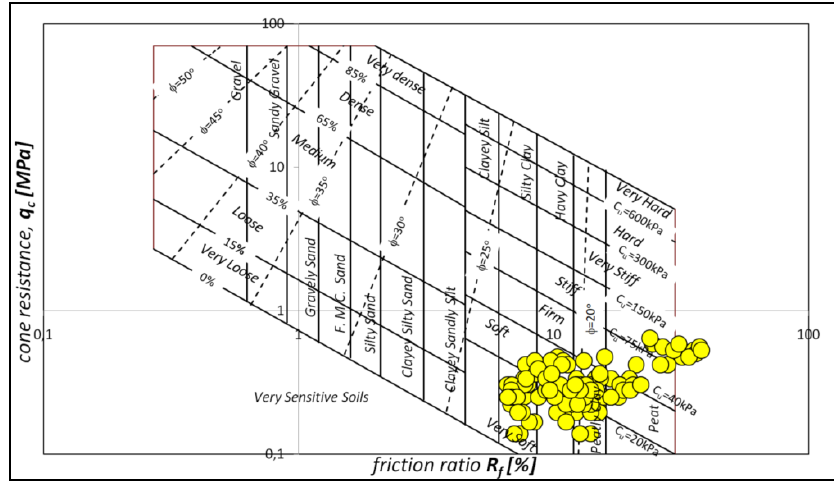
Figure 8. Diagrams present the identification of organic soils based on CPTM tests, according to the propositions of Searle’s nomogram.